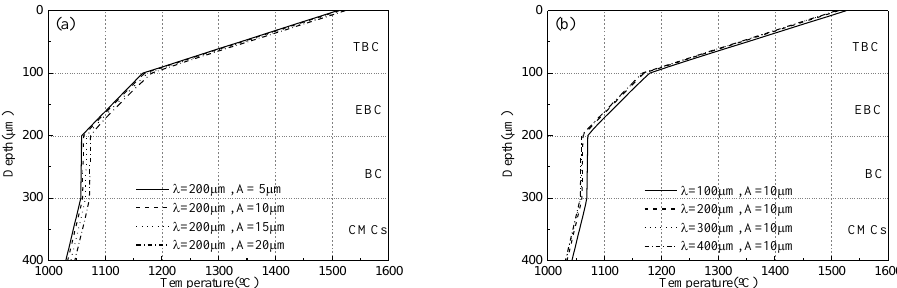
Figure 8. Variation of temperature versus depth of CMCs coatings under service conditions with different ( a ) amplitude; ( b ) wavelength.